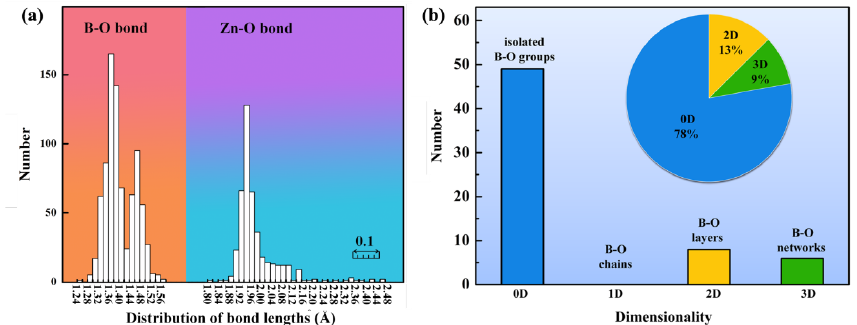
Figure 1. Distribution of ( a ) Zn-O and B-O bond lengths; ( b ) dimensionality of B-O configuration in zinc-containing borates.